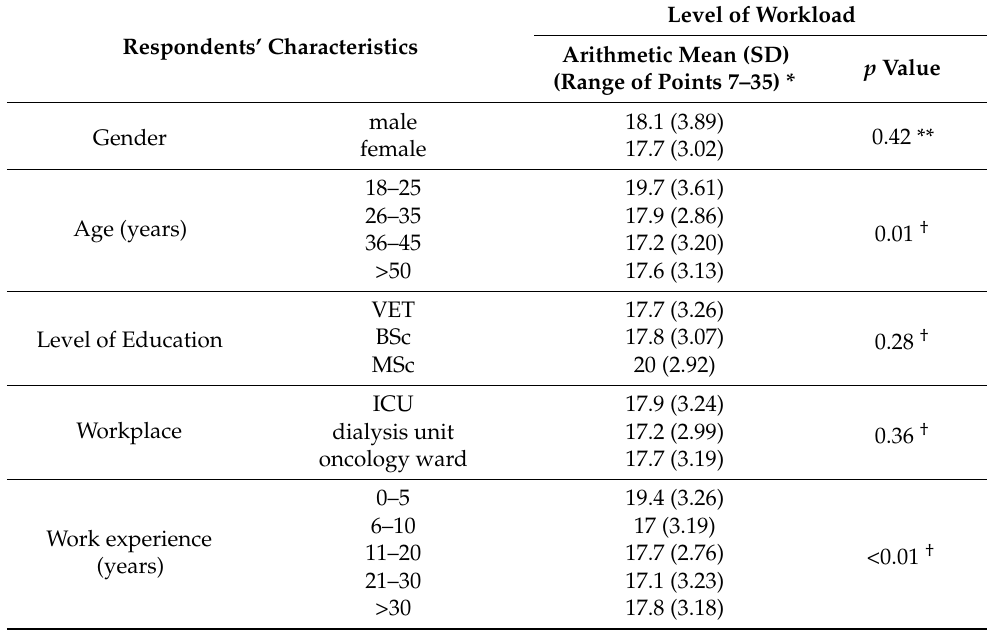
Table 5. Differences in respondents’ level of workload according to general characteristics (n =